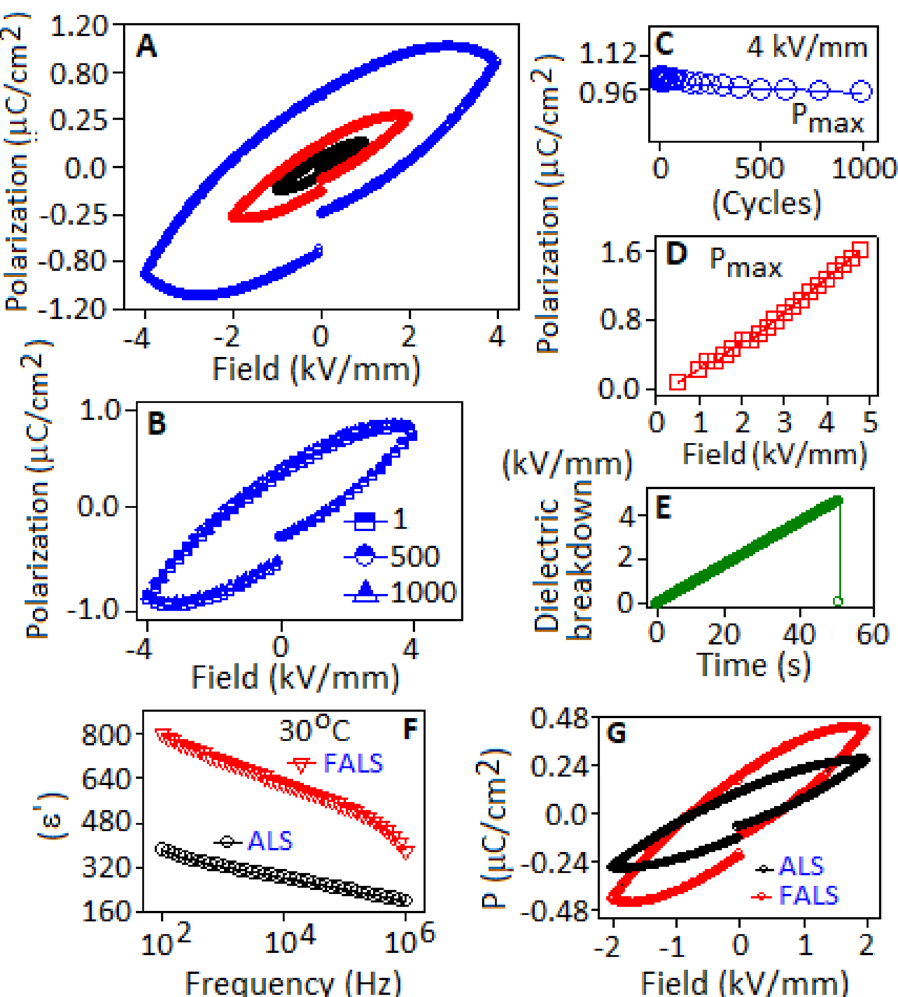
Figure 8. ( A ) Hysteresis loop, polarization vs electric field, of the FALS based device, measured at 100 Hz. ( B ) Hysteresis loop of the device under 4 kV/mm field condition, for 10 3 cycles. ( C ) Endurance behaviour of the device (in terms of maximum polarization, P max ) for 1000 cycles, at 4 kV/mm. ( D ) Increment of maximum polarization (P max ) values with respect to the applied electric field. ( E ) Dielectric breakdown strength (kV/mm) of the device as a function of time, measured at a scan rate of 200 V/s. Variation of ( F ) dielectric constant (ε ′ ) and ( G ) polarization vs electric field, hysteresis loop of ALS and FALS based